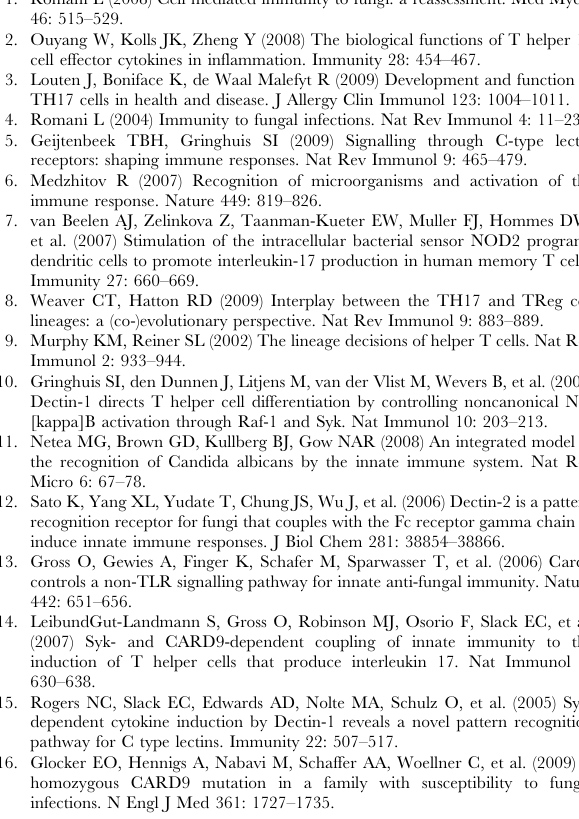
Figure S3 Malt1 paracaspase activity is required for c-Rel activation by dectin-1. Translocation of c-Rel, p65 or RelB (red) into the nucleus (Hoechst staining, blue; colocalization (Merge, pink)) in curdlan-stimulated DCs after Malt1 paracaspase inhibition by z-VRPR-FMK. Stainings are representative of two independent experiments. Figure S4 Dectin-1 and dectin-2 contribute to Candida spp.- induced cytokine expression. Cytokine production was determined by ELISA in supernatants of DCs stimulated with Candida albicans spp. (A), C. nivariensis or C. lusitaniae (B) in the absence or presence of blocking antibodies against dectin-1 and/or dectin- 2. Data are representative of two independent experiments. Found at: doi:10.1371/journal.ppat.1001259.s004 (2.36 MB TIF) Table S1 Expression primer